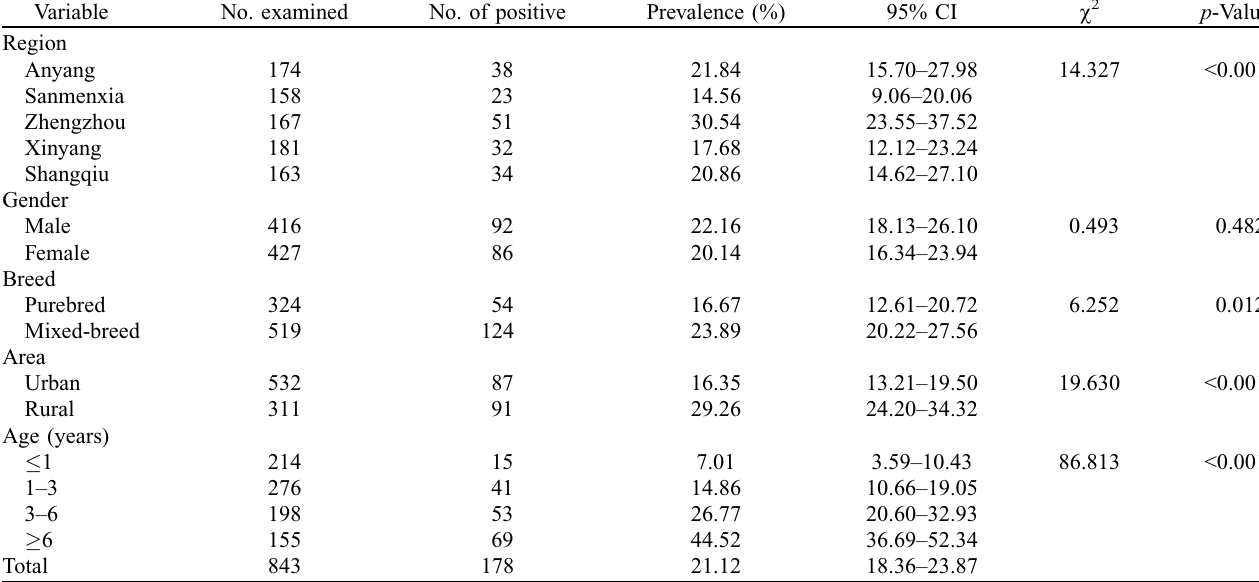
Table 1. Seroprevalence of Toxoplasma gondii infection in domestic cats in Henan province, central China.